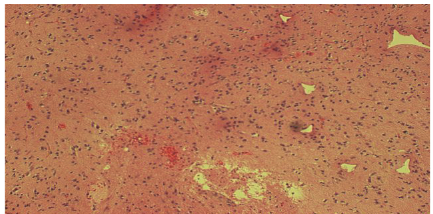
Figure 3: Brain tissue that is beginning to undergo changes of coag- ulation necrosis with focal hemorrhage and focal necrosis. There is tissue reaction with increased number of astrocytes, neutrophils, and edema.